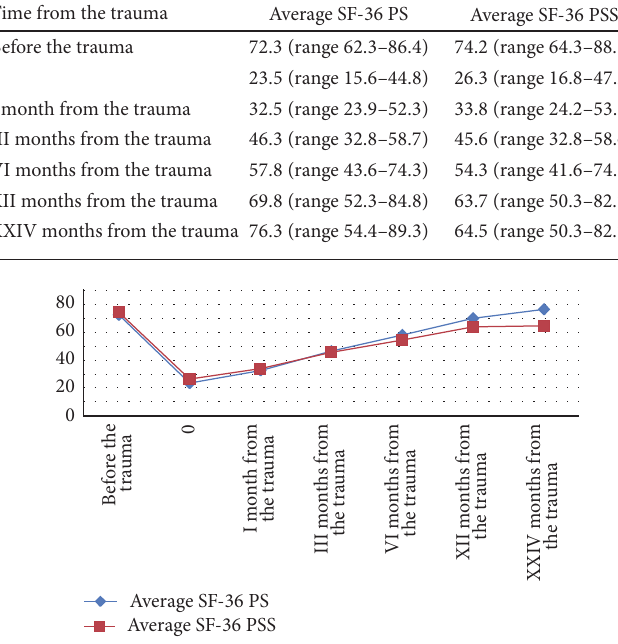
Figure 1: Trend of the follow-up to two years of quality of life measured by the Short Form (36) Health Survey (SF-36). At the sixth month of follow-up there was already a statistically significant difference ( 𝑝 < 0.05 ) in favor of the PS Group.